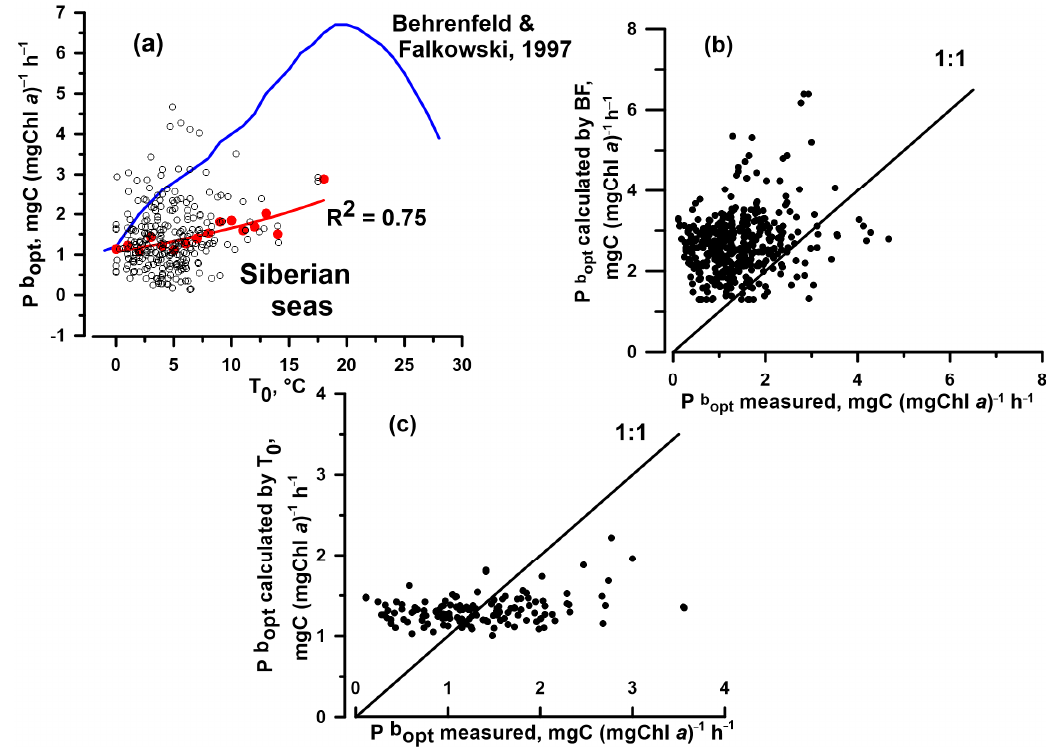
Figure 6. ( a ) the optimal assimilation number (P bopt ) vs. sea surface temperature (T 0 ) in the Siberian Seas (SSs) (open circles) in comparison with polynomial regression obtained by Behrenfeld and Falkowski [13] (BF-model) based on the worldwide dataset (the blue line). Red colour indicates the exponential relationship between P bopt and T 0 obtained based on the SSs dataset (T_ reg —algorithm). ( b ) A comparison of the values of P bopt measured and calculated using the BF-model. ( c ) A comparison of the values of P bopt measured and calculated using T_ reg . The solid line indicates a 1:1 correlation.